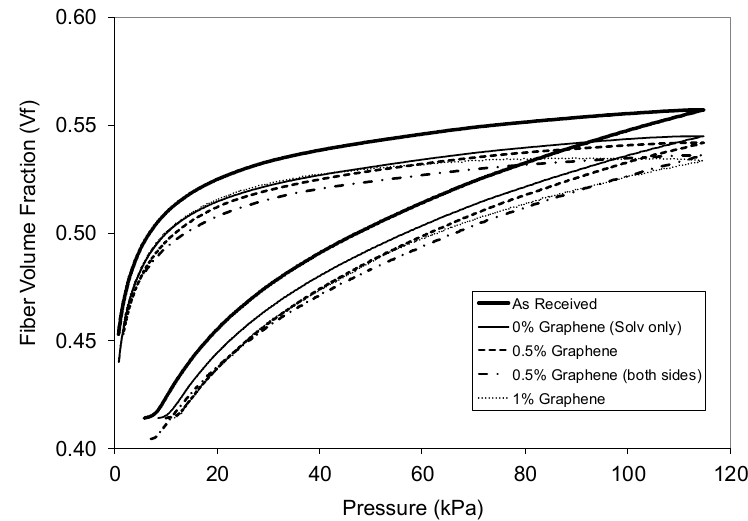
Figure 6. Compaction response of different percentages of graphene coated glass fiber reinforcement.